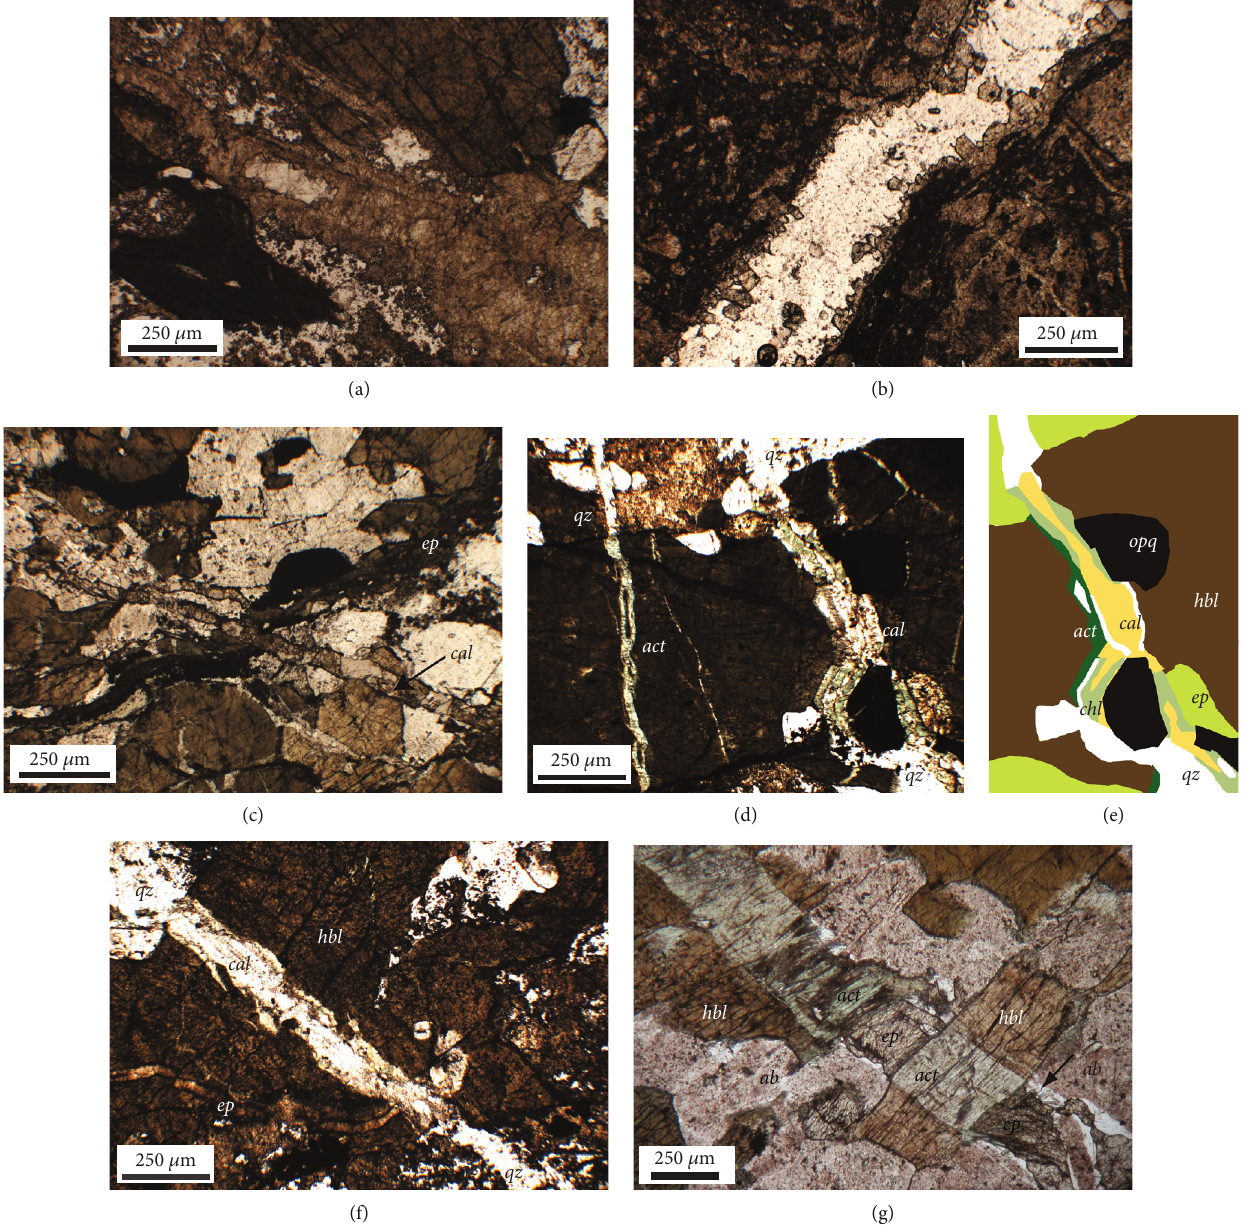
Figure 6: Photomicrographs of veins. (a) Coarse-grained epidote vein, with central area containing quartz with actinolite needles, cutting across hornblende in altered gneiss (thin section I) (PPL); (b) quartz and epidote- fi lled vein cutting across epidosite. Marginal epidote shows euhedral shapes (thin section I) (PPL). Quartz has mylonite texture shown in Figure 4(f); (c) calcite- fi lled vein crosscutting thin epidote-bearing sheared vein (thin section G) (PPL); (d) complex fi ll of quartz- fi lled veins as they cut through a hornblende in the host altered gneiss (thin section I) (PPL). Vein on left shows quartz- fi ll cutting through epidote (top of view) and actinolite- fi ll, in optical continuity with the host hornblende, where the vein cuts the amphibole host. The vein on the right has quartz- fi ll at top and base of view where it cuts epidote and quartz in the wall rock and calcite-chlorite-actinolite- fi ll where it cuts through wall rock hornblende; (e) cartoon showing summary of mineral textures for the thick vein shown in (d); (f) quartz- fi lled vein transforming into calcite- fi lled vein with marginal actinolite, where it cuts hornblende in the host gneiss. Note thin epidote vein cuts across hornblende host (thin section I) (PPL); (g) actinolite- and epidote- fi lled fracture in the sample of gneiss from the southwest of Iona collected by Fiona Fraser (Sample F464, in Hunterian museum collection (Entry 666), Grid Ref NM253 221) showing variation in fracture fi ll controlled by the mineralogy of the adjoining host. The arrow shows clear albite at the edge of the vein with epidote fi